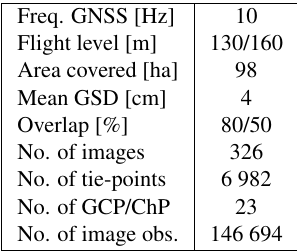
by differencing.